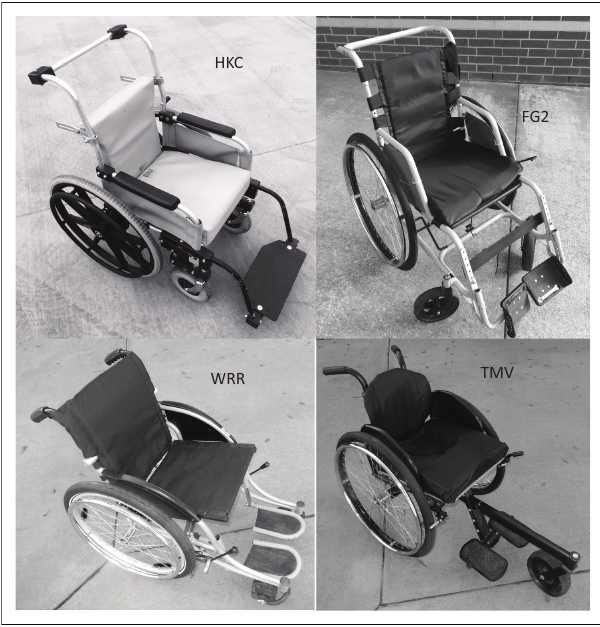
FIGURE 1: The wheelchairs utilised, shown as they were commonly configured at our location for active users and the way they were configured for this study.